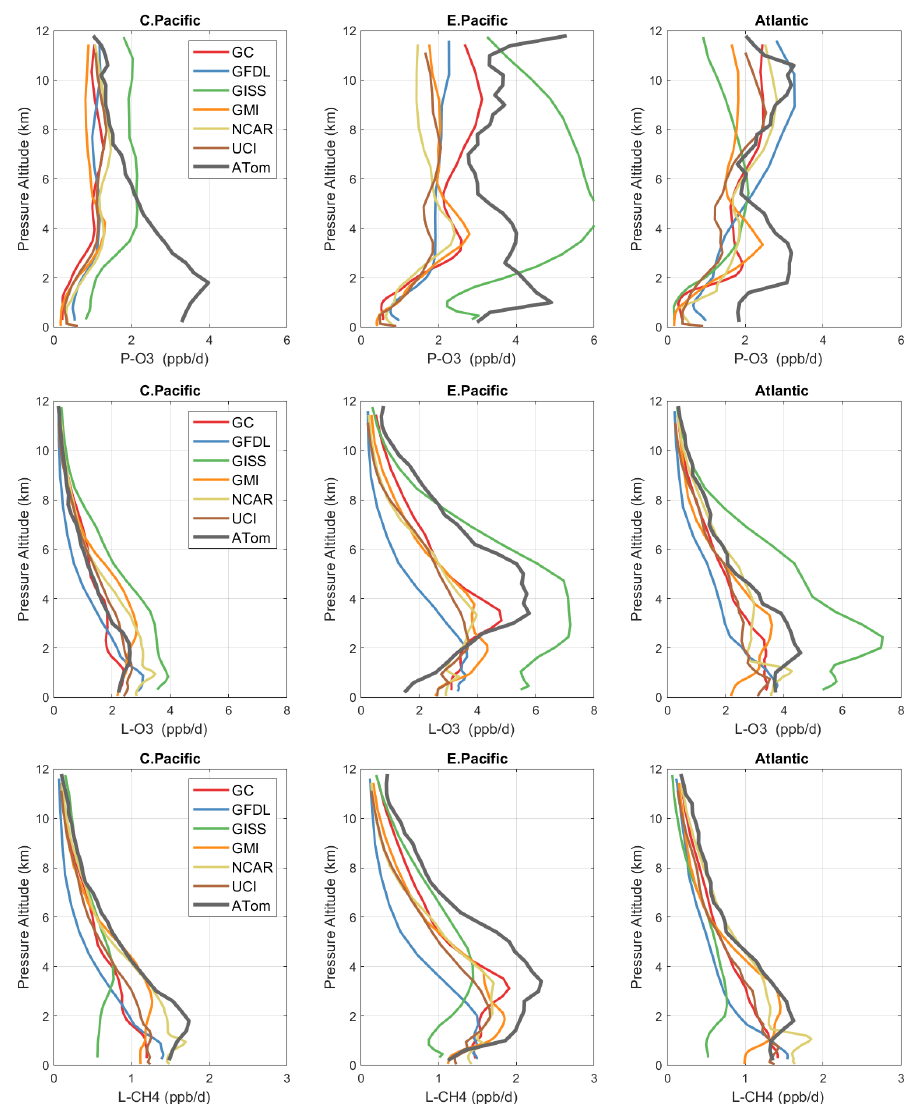
Figure 3. Mean profiles of reactivity (rows: P-O3, L-O3, L-CH4 in ppb/d) in three domains (columns: C. Pacific, 30 ◦ S–30 ◦ N by 180–210 ◦ E; E. Pacific, 0–30 ◦ N by 230–250 ◦ E; Atlantic, 30 ◦ S–30 ◦ N by 326–343 ◦ E). Air parcels are cosine(latitude)-weighted. ATom-1 (gray) results are from Fig. 2, while model results are taken from the August climatologies in Prather et al.